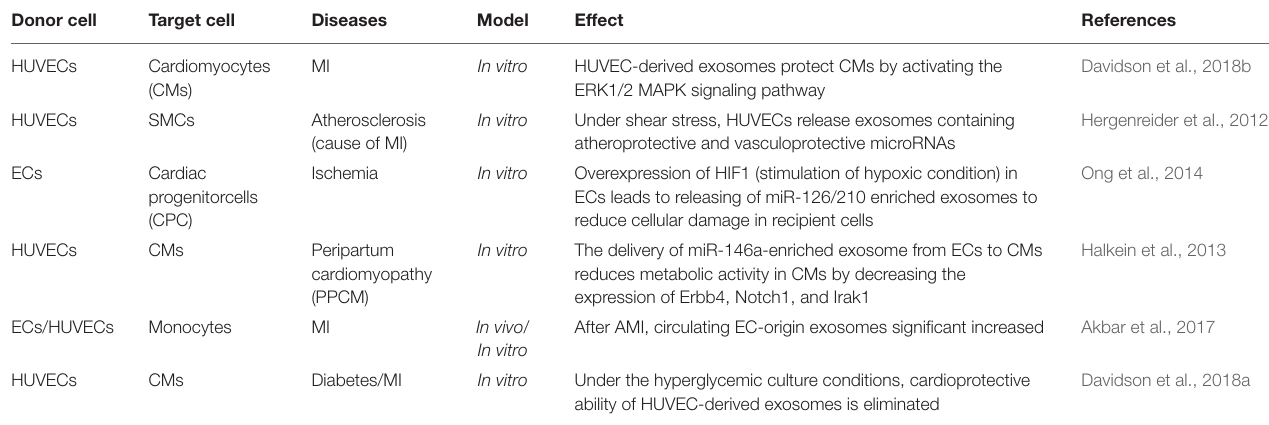
TABLE 3 | Studies demonstrating endothelial cell-derived exosomes in pathophysiology of heart diseases. Donor